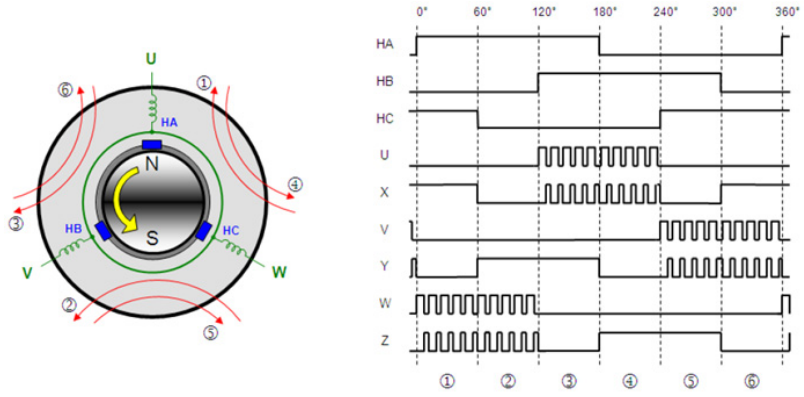
Figure 9. PWM-PWM Commutation at CW/CCW = 0.